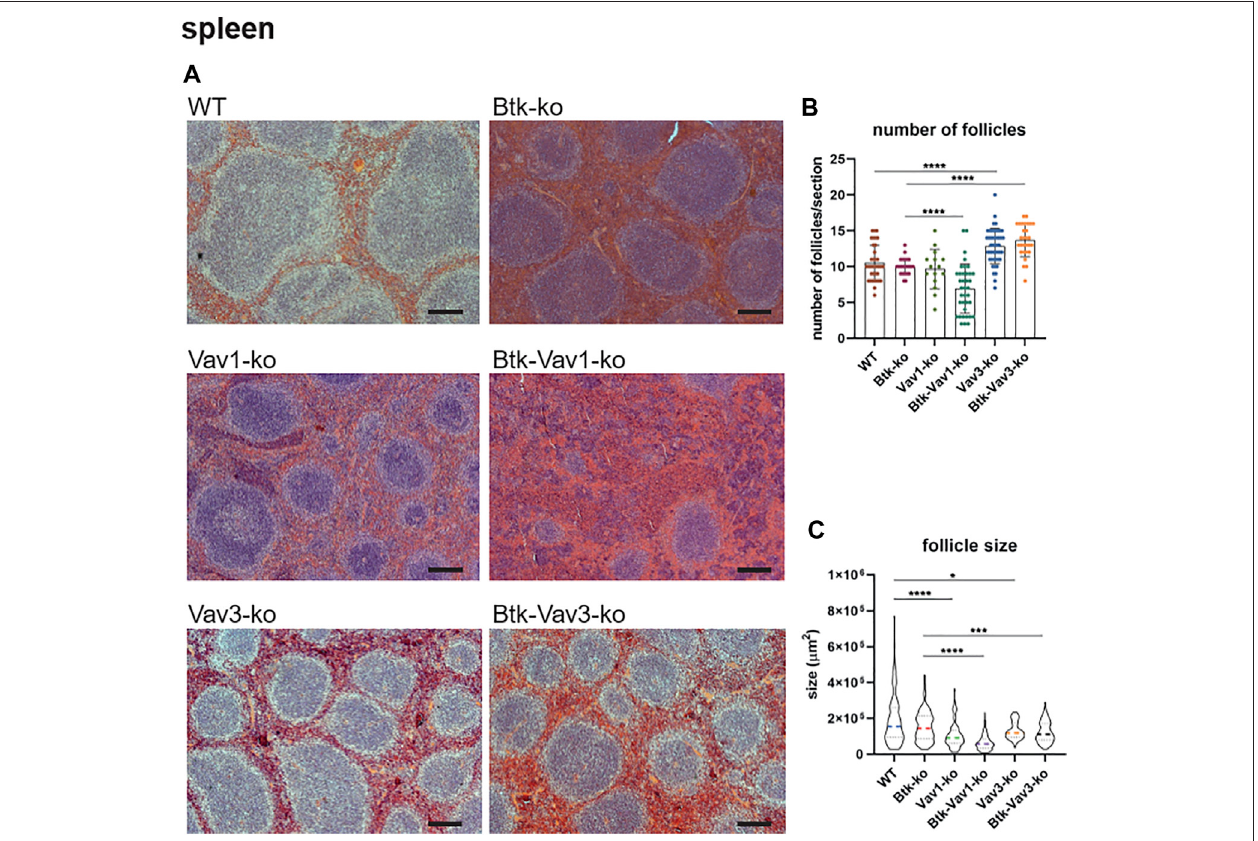
FIGURE4| Vavproteinde fi ciencycausesdisturbedsplenicmicroarchitecture. (A) RepresentativeHE-stainingsofsplenicsectionsScalebarindicates200 µm. (B, C) Statistical analyses showing number of follicles (B) and follicle size (C) determined within a certain section. Three sections were analyzed per animal. Each point representsoneanalyzedimagesection.Datainthegraphsareshownasmeans±SD.SpleensofWT( n =12),Btk-ko( n =9),Vav1-ko( n =5),Btk/Vav1-ko( n =13),Vav3- ko ( n =15) and Btk/Vav3-ko ( n = 9)animalswere stained and analyzed. Data aremerged from at least three independent experiments. * p < 0.05, ** p < 0.01, *** p < 0.001, and **** p < 0.0001. p -values were determined using atwo-tailed Student ’ s ttest or Mann-Whitney-U test. Mice were analyzed in an age range from 9 – 13